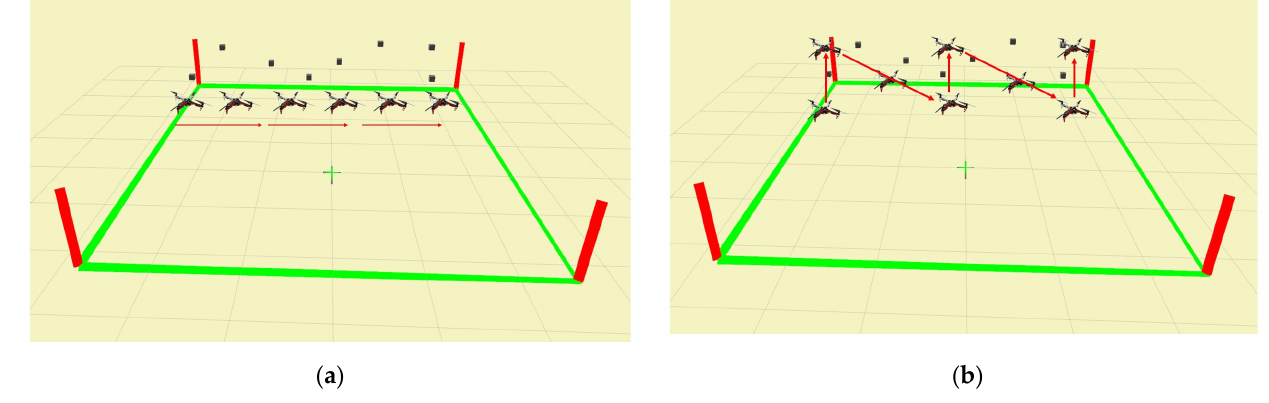
Figure 9. ( a ) The straight-line trajectory; ( b ) The zig-zag trajectory in the experiment.